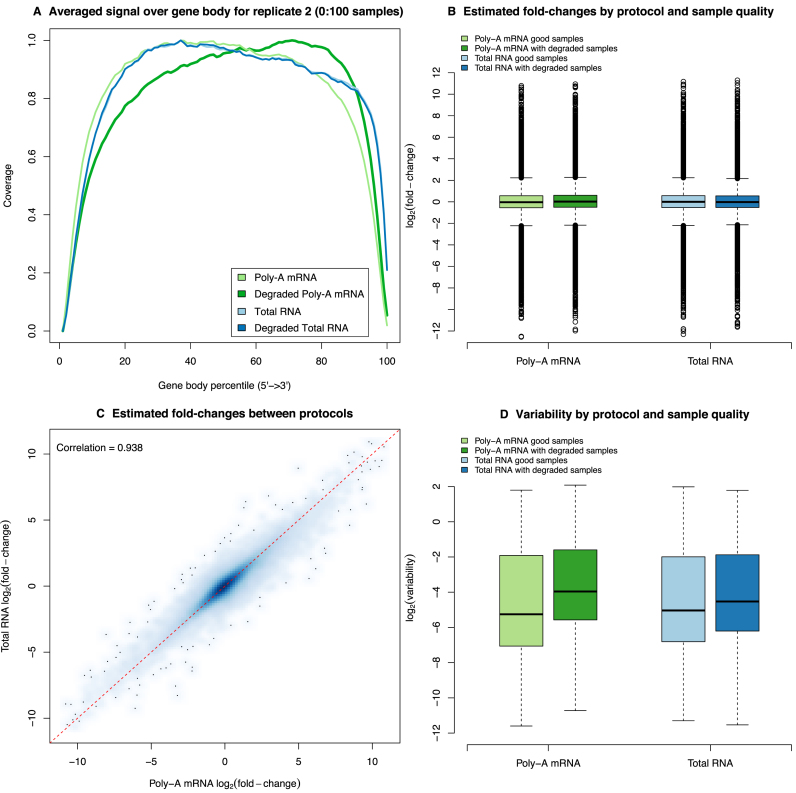
A comparison of library preparation protocols. (A) Plot of read coverage generated by RSeQC for a representative sample from replicate 2. Coverage is fairly uniform for both good quality and degraded total RNA samples and for the good quality poly-A mRNA sample there is a slightly lower coverage at the 3΄ end. For the degraded poly-A mRNA sample, the 5΄ end reads are under-represented in this library. (B) Boxplots for the estimated log-FC (Mg) by protocol and degradation state from the non-linear model fit across all genes. Irrespective of protocol and whether degraded samples are included, we see a good dynamic range, indicating that there are no systematic biases between the different protocols. (C) Smoothed scatter plot of the estimated log-FC (Mg) for the total RNA protocol versus the poly-A mRNA protocol based on the good quality samples. The red dashed line represents the equality line. This plot shows good agreement between library preparation methods with no systematic bias. (D) Boxplots of variability (\documentclass[12pt]{minimal}
\usepackage{amsmath}
\usepackage{wasysym}
\usepackage{amsfonts}
\usepackage{amssymb}
\usepackage{amsbsy}
\usepackage{upgreek}
\usepackage{mathrsfs}
\setlength{\oddsidemargin}{-69pt}
\begin{document}
}{}$\log _2\hat{\phi }_g^2$\end{document}) by protocol and degradation state from the non-linear model fit across all genes. As for the read coverage plot, we see that the poly-A mRNA analysis that includes the degraded samples has systematically elevated levels of variability relative to the other analyses.